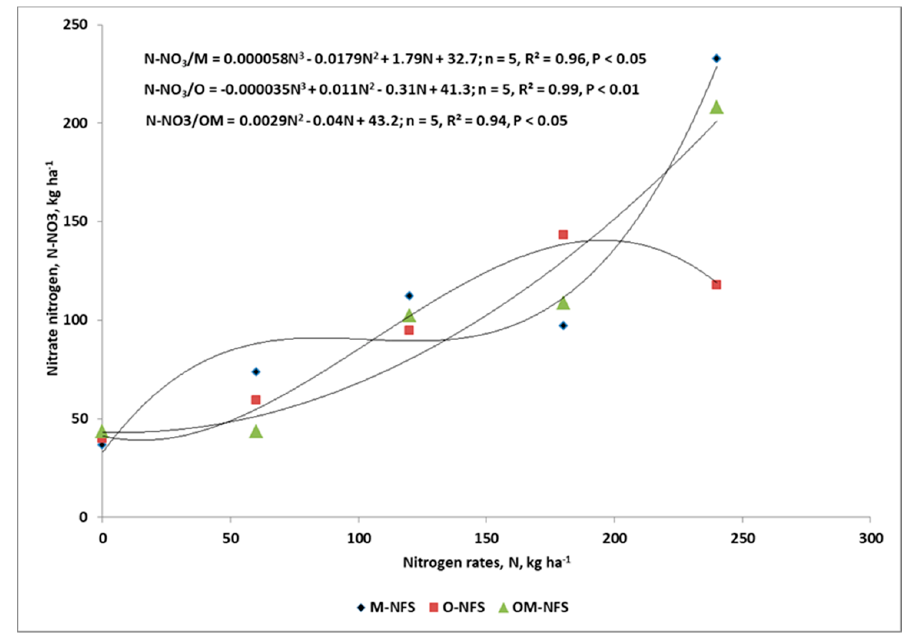
Figure 2. Trends in the nitrate N content at the onset of WOSR stem elongation stage of growth for three nitrogen fertilization systems (NFSs). M-NFS, O-NFS, OM-NFS—mineral, organic, organic-mineral, respectively.